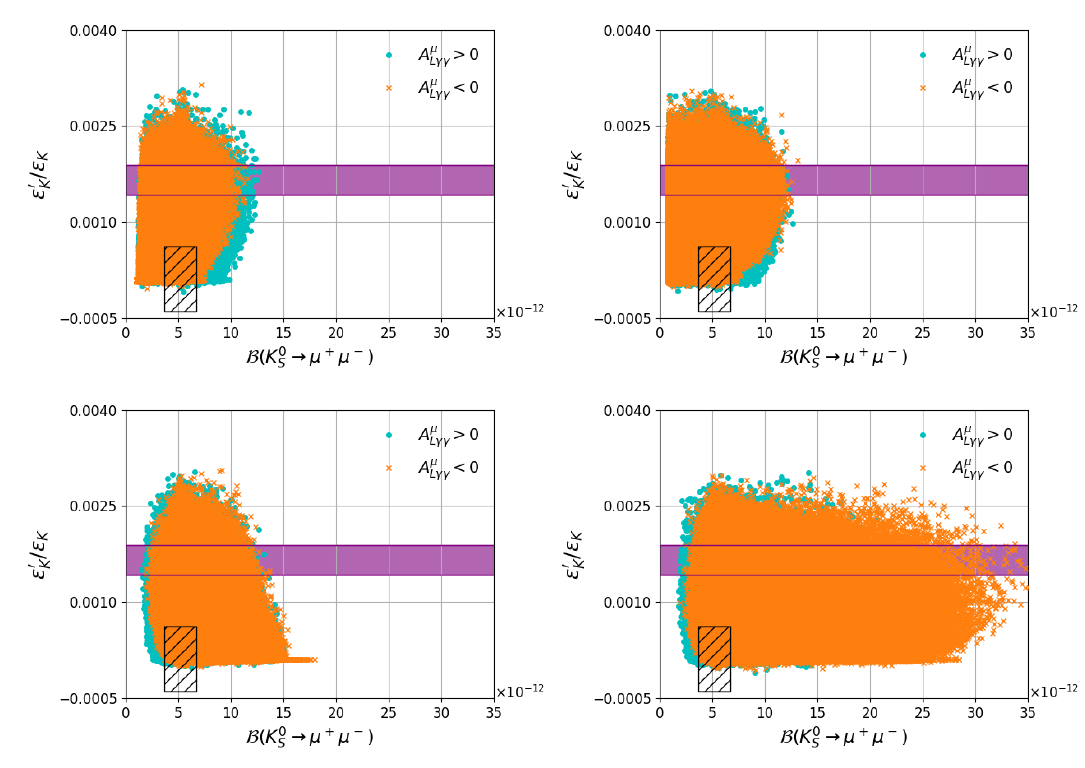
0 (cid:0) (cid:1) Figure 3 . Scenario A " vs. B ( K 0 ! (cid:22) + (cid:22) (cid:0) ) for (cid:14) LL 6 = 0 and ( M 3 (cid:1) (cid:22) ) > 0 (upper left), K S d " K 12 (cid:0) (cid:1) (cid:0) (cid:1) (cid:14) LL 6 = 0 and ( M 3 (cid:1) (cid:22) ) < 0 (upper right), (cid:14) RR 6 = 0 and ( M 3 (cid:1) (cid:22) ) > 0 (lower left), and d d 12 12 (cid:0) (cid:1) (cid:14) RR 6 = 0 and ( M 3 (cid:1) (cid:22) ) < 0 (lower right). The cyan dots correspond to A (cid:22) d 12 crosses to A (cid:22) < 0. The deep purple band corresponds to the experimental results and the hatched L(cid:13)(cid:13) area to the SM